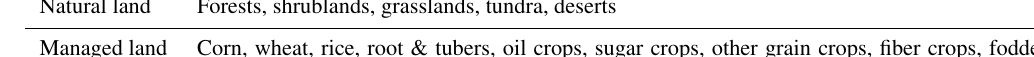
Table 1. Terrestrial land types in GCAM. Natural land